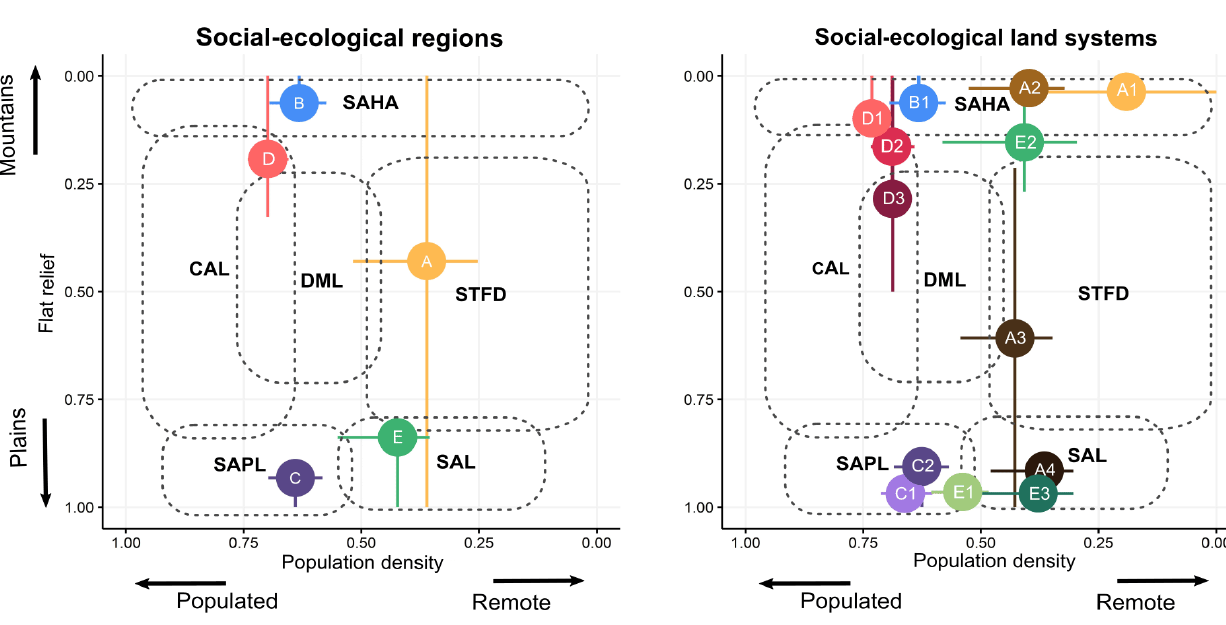
Fig. 3 . Overlap diagram of conceptual social-ecological land systems (SELS; Boillat et al. 2017) and spatial social-ecological regions (SER; left) and spatial SELS (right) along two gradients of population and terrain roughness. Circles represent the mean values and bars represent the first to third quantile range of the spatial SELS percent of flat land (y axis) and population density (x axis). Dashed lines depict the hypothetical distribution of the conceptual SELS along those axes. Acronyms refer to the conceptual SELS from Boillat et al. (2017): SAHA = South American highlands and altiplano; CAL = coastal agricultural lands with long colonization history; DML = dry and mediterranean lands; SAL = South American Lowlands: new agropastoral areas; SAPL